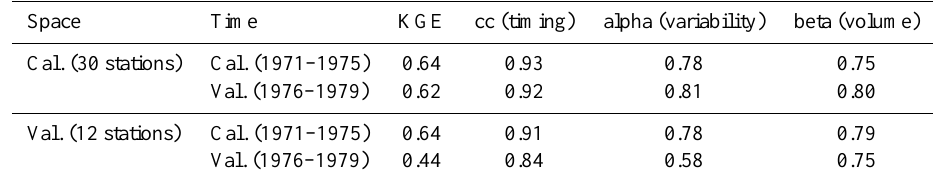
Table 3. Median model performance for calibration and validation stations and